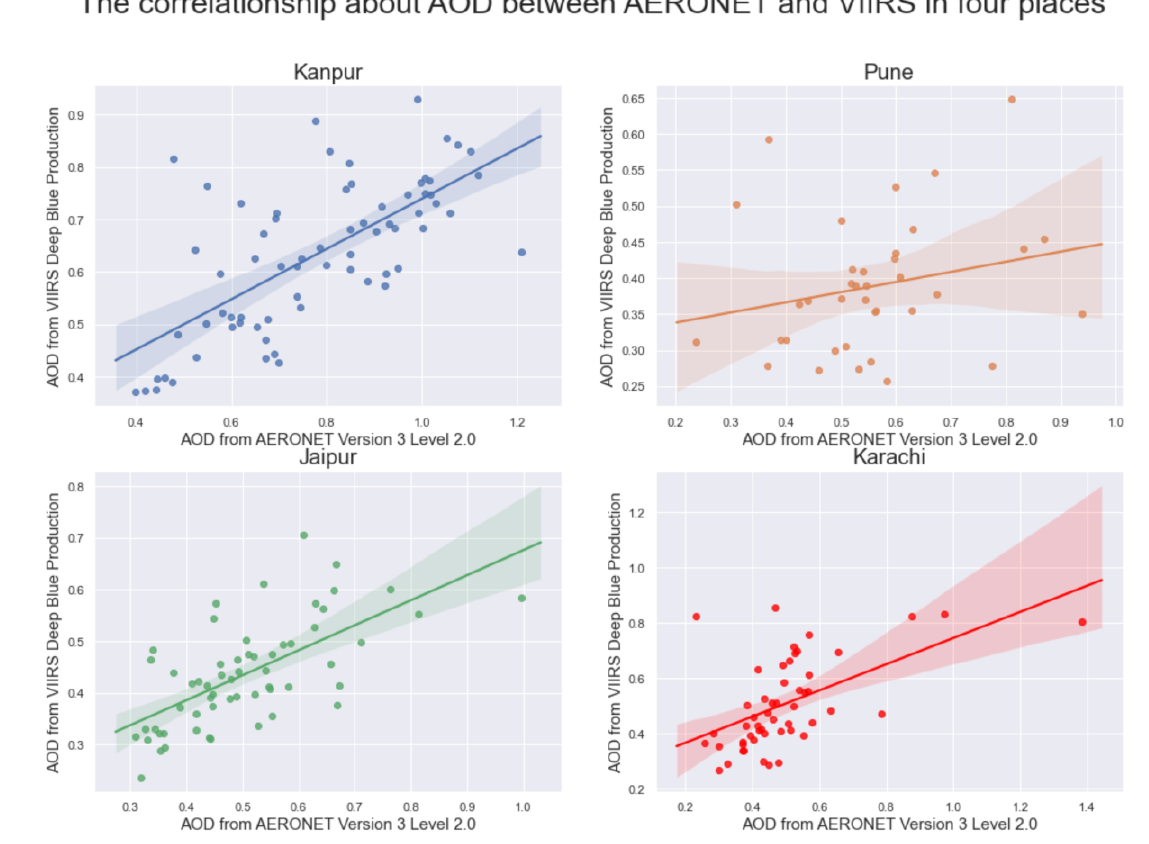
Figure 10. Regression plots about the AOD from AERONET Version 3 Level 2.0 dataset against AOD from VIIRS Deep Blue Production in four stations of India and Pakistan (different colored lines and points suggest data from different